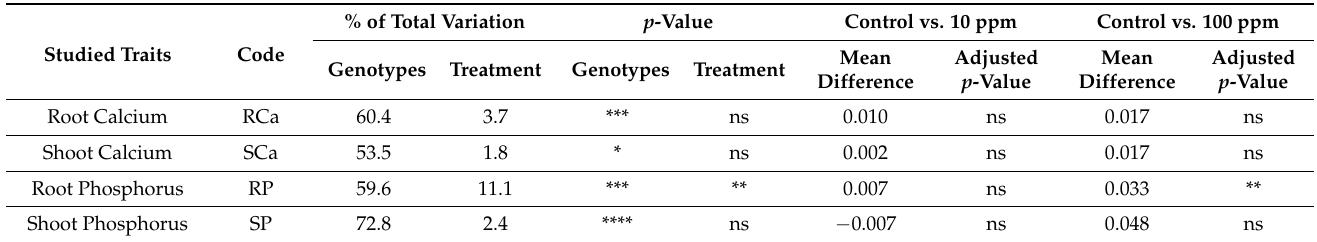
Table 2. The two-way analysis of variance (ANOVA) to understand the effect of genotypes (G) and treatments (T) on the variance in elemental uptake. Significant differences are presented as **** for p < 0.0001; *** for p < 0.0005; ** for p < 0.005; * for p < 0.05; ns, non-significant.